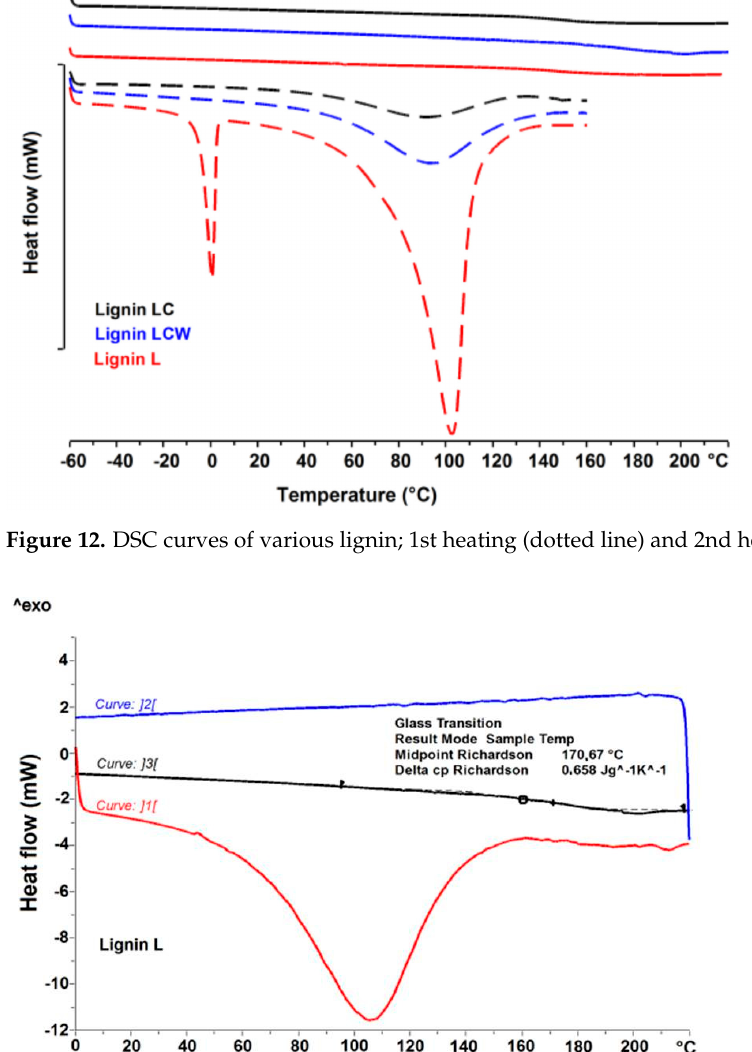
for Lignin L. Figure 13. DSC determination of glass transition temperature (T g ) and change in heat capacity (C p )